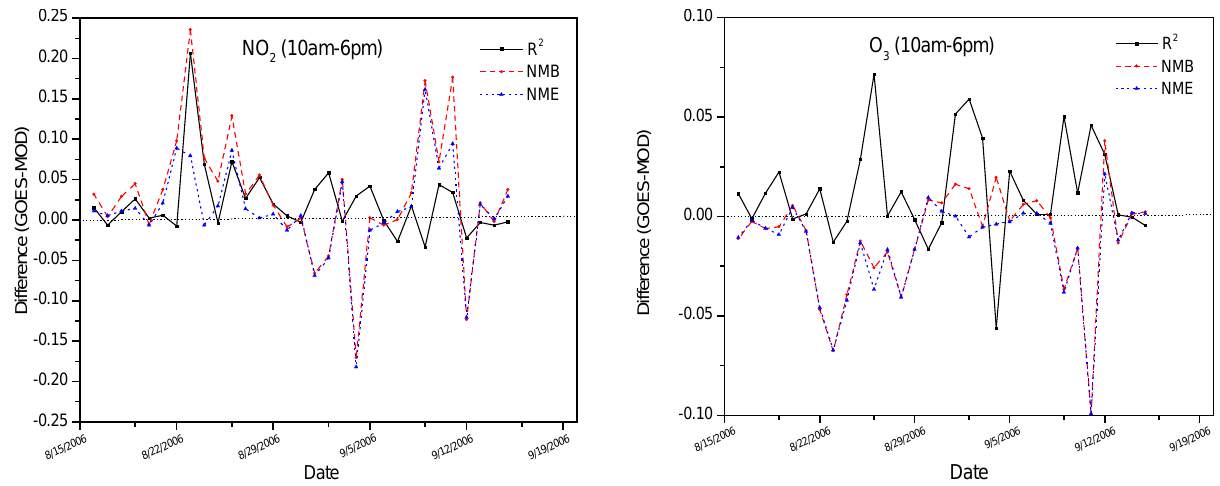
Figure 4. Change in model performance ( R 2 , NMB, and NME) in simulating daily 8h (10:00–18:00LT) NO 2 (left) and O 3 (right) caused by satellite-derived photolysis